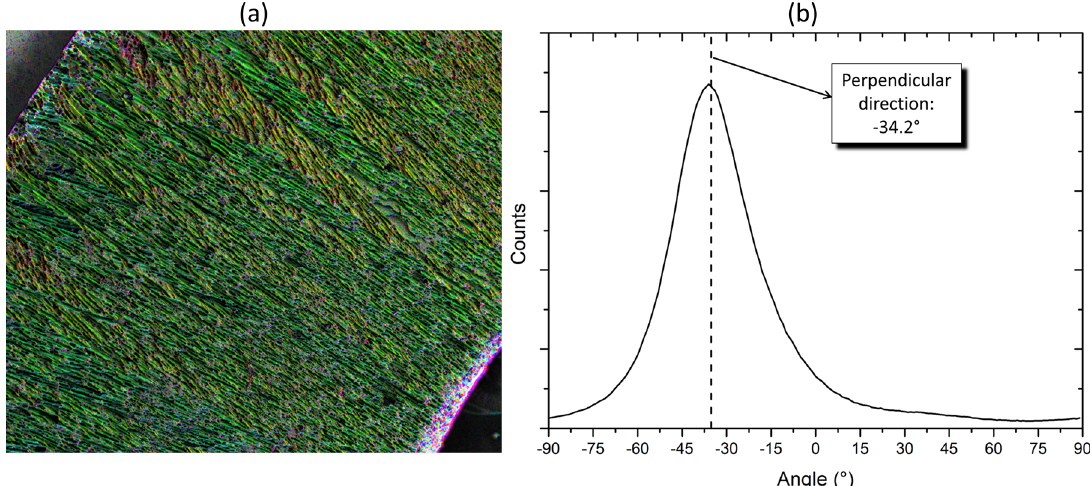
Figure 4. Pore directionality of the freeze-cast pores measured by the OrientationJ plugin on ImageJ: (a) color map of the pore directionality and (b) pore directionality distribution. and produces a material suitable to withstand pressures